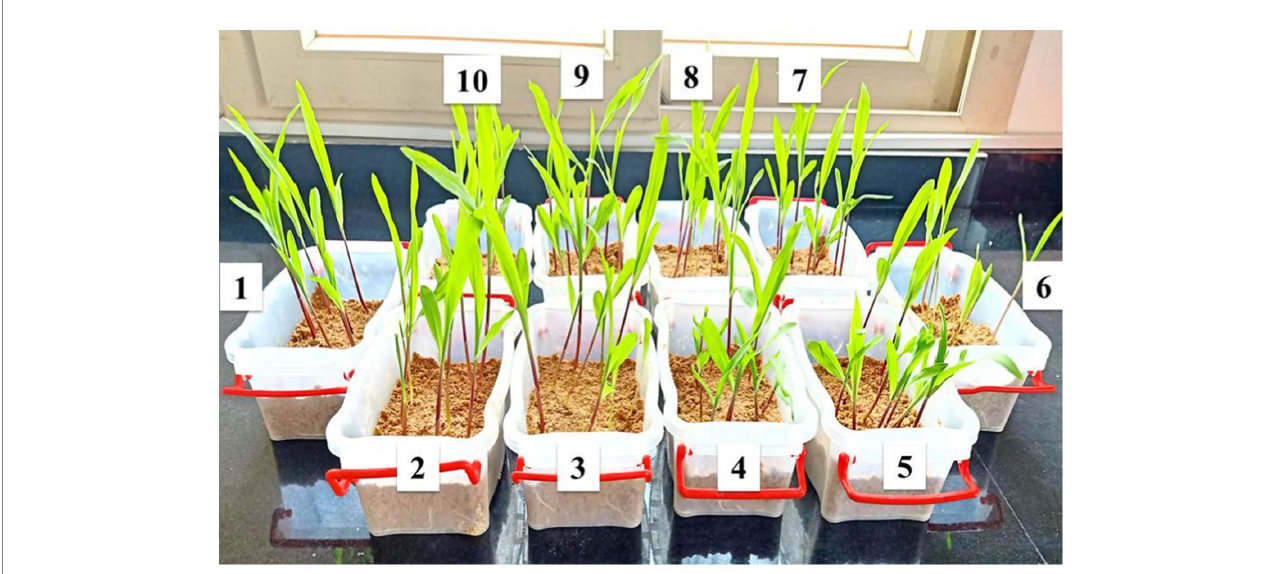
FIGURE 8 Representative infected samples at 14 days after treatment with the produced nanoemulsions in compared to the chemical fungicide used (1) non-treated control plants (non-infected); (6) non-treated control plants (infected); (5) Nigella Sativa oil; (7) fungicide; (2–4) 10_T80, 5_T80, and 0_T80 respectively; and (8–10) 0_T20, 5_T20, and 10_T20, respectively.